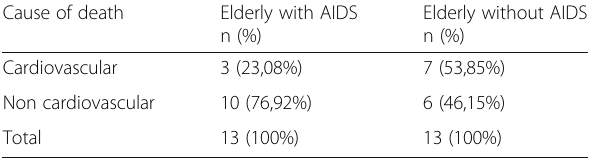
Table 2 Distribution of the cause of death of elderly people, with and without Aids, autopsied in the period from 1982 to